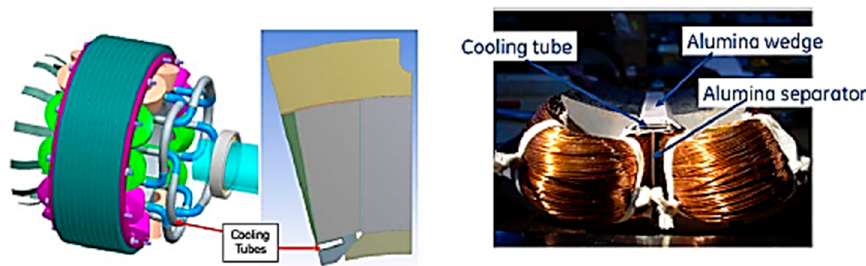
Figure 26. Structure of cooling tubes inside stator slots [68].